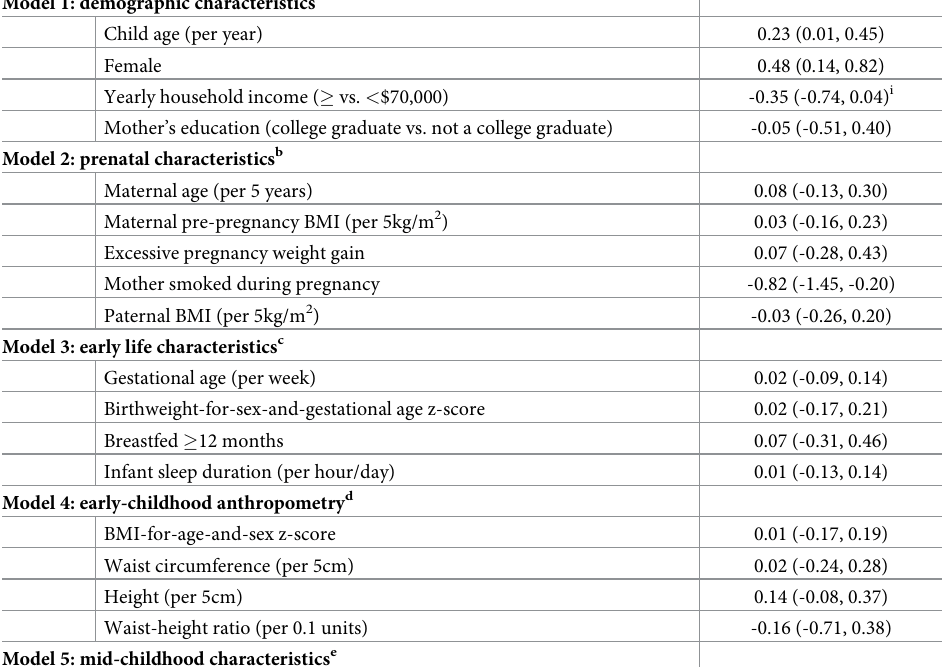
Table 3. Associations ( β [95% CI]) of prenatal, parental, and child characteristics with change in hair cortisol con- centration a from mid-childhood to early adolescence in White children (n = 426). Model 1: demographic